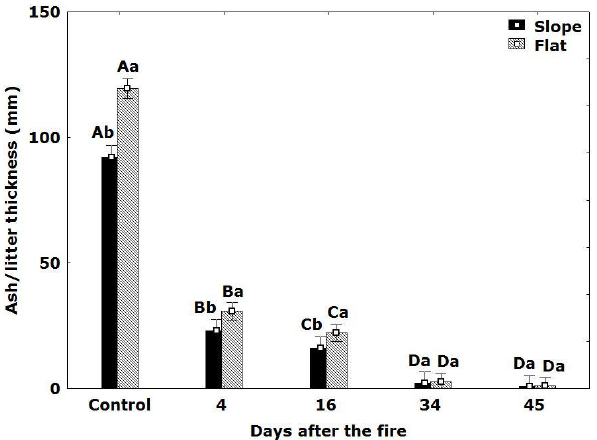
Fig. 6. Evolution of mean litter and ash thickness from the flat and sloping area in the post-fire period (bars show 95% confidence intervals). Different letters indicate significant differences ( p< 0 . 05) between dates (capital letters) and ash types (low-case letters).